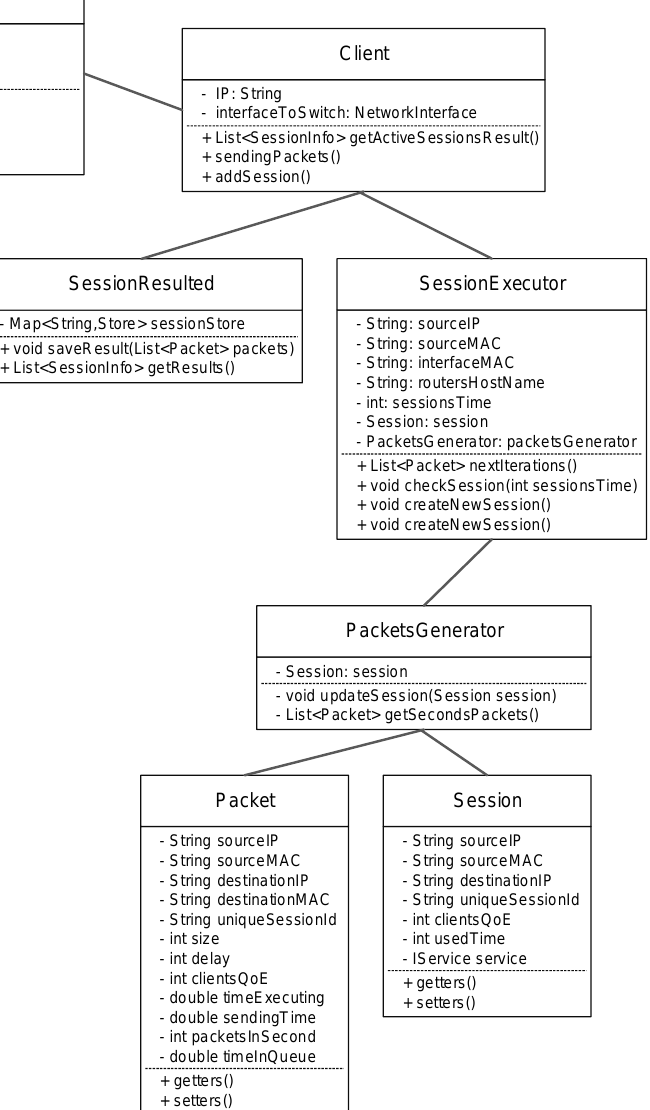
Figure 9. The UML (Unified Modeling Language) diagram of the customer class and classes dependent on it.